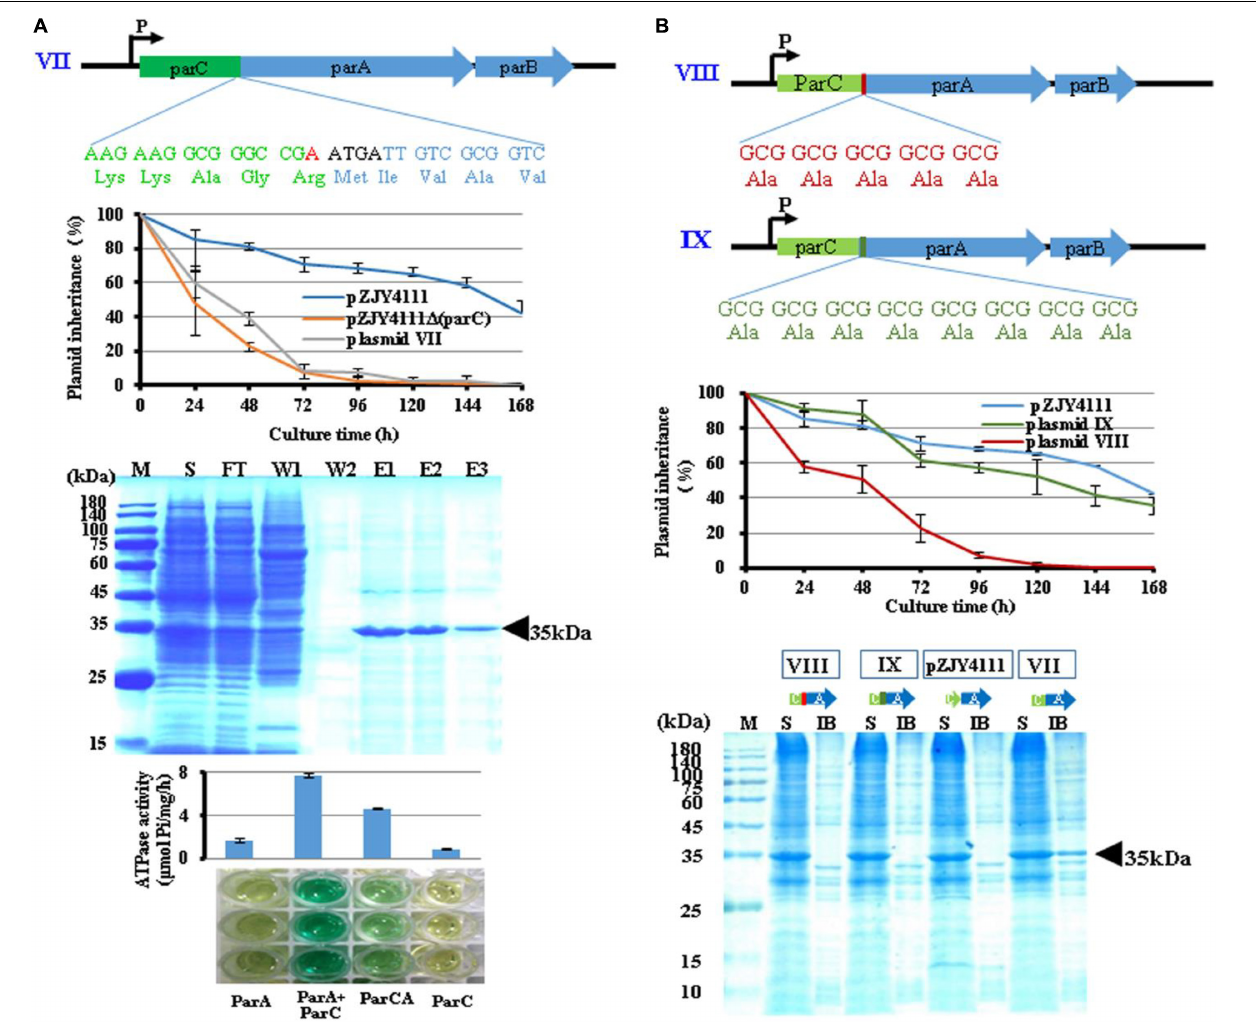
FIGURE 3 | Properties of ParCA fusion proteins. (A) An adenylate (red) was inserted before the overlapping region (ATGA) to destruct the stop codon (TGA) of parC , forming a fused ParCA (plasmid VII). The ParCA fusion protein was expressed in E. coli BL21(DE3) cells after IPTG induction and further purified. (B) Adding a 5 × Ala linker (VIII) or an 8 × Ala linker (IX) between domains C and A in ParCA fusion protein. Inheritance stabilities of different plasmids were assayed in M. xanthus DZ1. Error bars indicate the SD of four or six independent experiments. Soluble expression of the ParCA fusion proteins with a 5 × Ala linker (VIII) or an 8 × Ala linker (IX) between the C and A domains. M, protein standard; S, supernatant; IB, inclusion body; FT, flow through; W, washing with 20 mM imidazole; E,